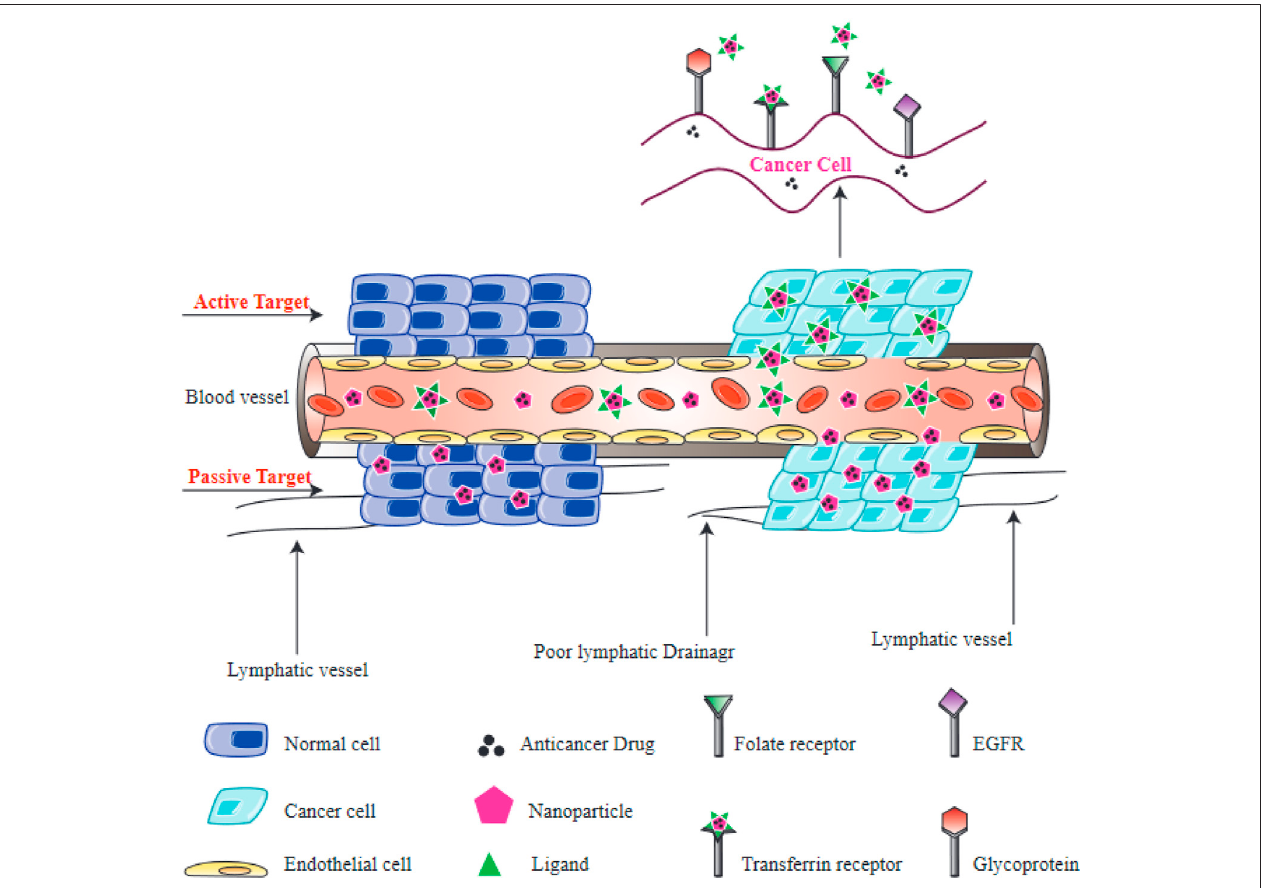
FIGURE 6| Active and passive targeting ofNPs to tumors. Passivetargetingof NPs isprimarily mediated by the enhanced permeability and retention (EPR) effect, which depends on leaky vasculature and defective lymphatic drainage of tumors. Active targeting of NPs is mediated by interactions between receptors on cells and ligands on NPs. Folate receptors, transferrin receptors, epidermal growth factor receptor (EGFR), and glycoprotein receptors (lectins) are all found on the surface of cancer cells.